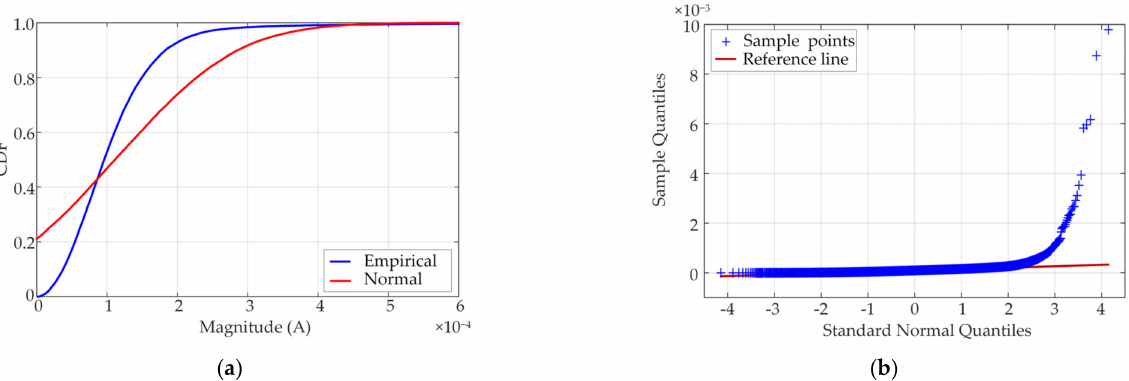
Figure 10. The frequency-domain distribution diagram of the measured signal. ( a ) CDF distribution curve of the measured signal. ( b ) Q–Q plot of the measured